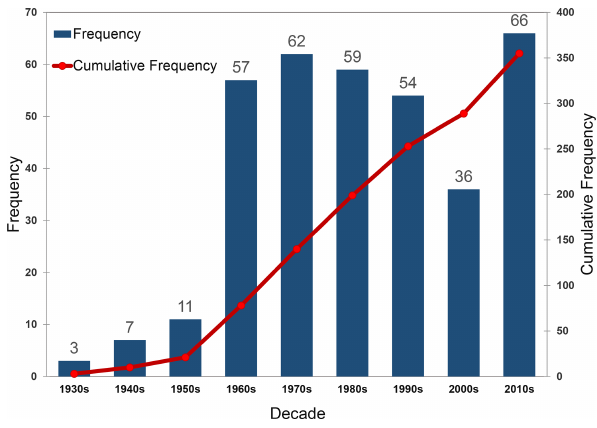
Figure 1. Decadal frequency and cumulative frequency of tail- ings dam breaches worldwide ( n = 355) between 1930 and 2019. Sources: Chambers and Bowker (2019), ICOLD, UNEP (2001), and WISE